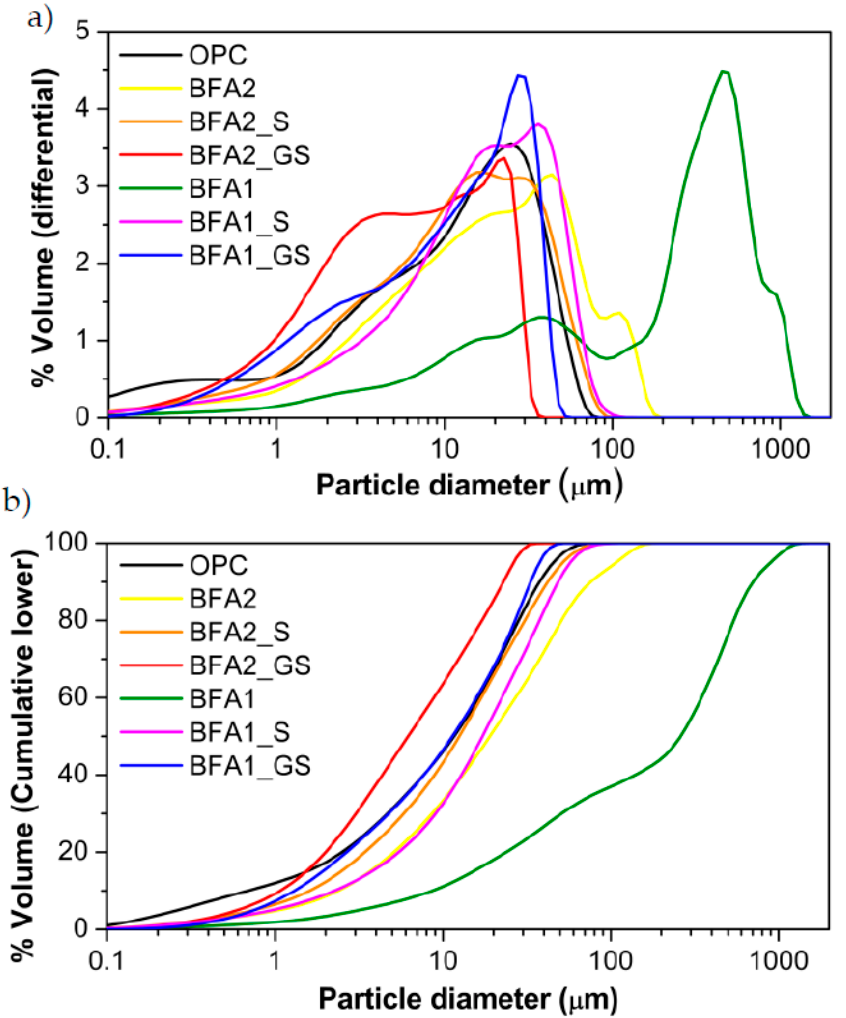
Figure 1. Particle size distribution (volume basis) of the OPC, and BFA as received and pre-treated: ( a ) differential, and ( b ) cumulative lower. Figure 2 shows micrographs of OPC, BFA1 and BFA2, as received and pre-treated. The detail of the surface of the particles of OPC, BFA1 and BFA2 is patent in Figure 2a,c,d, respectively. BFA particles have a rougher surface than OPC ones. As-received BFA (BFA1— Figure 2e and BFA2—Figure 2f) is composed of irregularly shaped particles with a broad particle size range (between only a few microns and more than 100 µ m). OPC (Figure 2b) is constituted by smaller and less angular particles and a narrower size distribution when comparing to BFAs. In Figure 2g,h is clear the smaller particle size that results from the sieving procedure. Grinding and sieving lead to a BFA with a very different particle morphology. The mean particle diameter was decreased and the particle size distribution was narrowed (Figure 2i,j) by turning irregularly shaped particles into smaller and less angular ones, so more similar to OPC ones. These observations are in accordance with the Coulter results (Table 2 and Figure